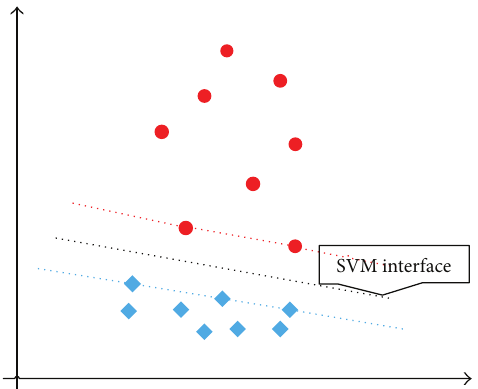
Figure 2: A heterogeneous distribution of the initial instances for C-SVM, Hypothesis 1: the number of the positive instances is much greater than the number of negative instances.